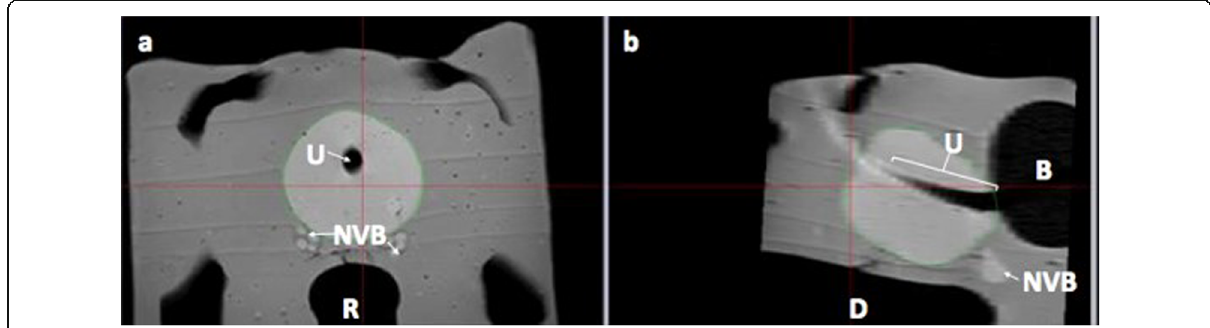
Fig. 5 Contoured prostate capsule. a Axial and ( b ) sagittal T2-weighted magnetic resonance images. Note the pelvic phantom model urethra (U), rectum (R), bladder (B), and neurovascular bundles